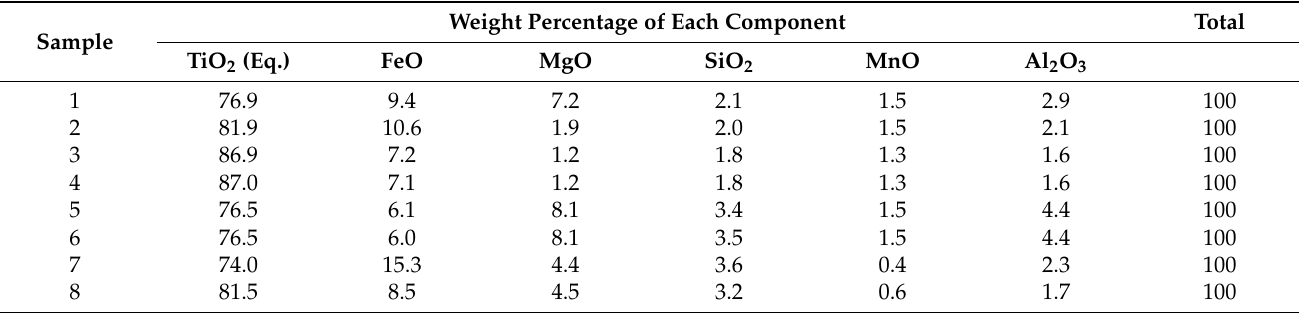
Table 2. XRF analysis of different ilmenite slag samples.